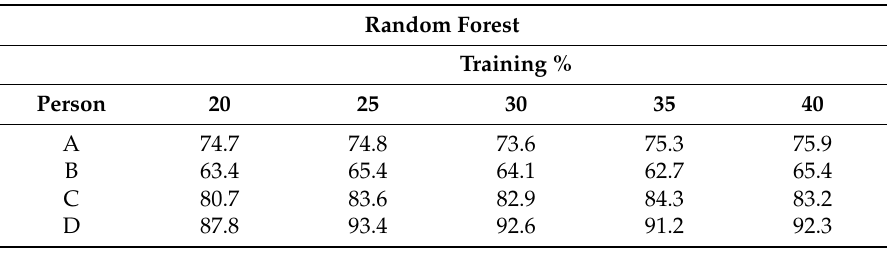
Table 3. Random Forest (RF) Classifier results from each individual person. Random